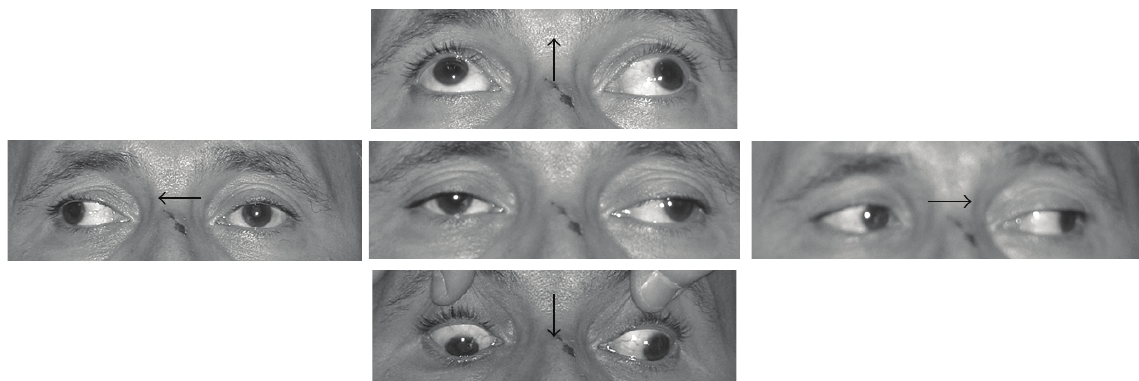
Figure 1: The left eye adduction deficit and ptosis in the patient. Note the slight ptosis also in the right eye. The left CN III deficit persisted unmodified after treatment with IVIg and methylprednisolone.